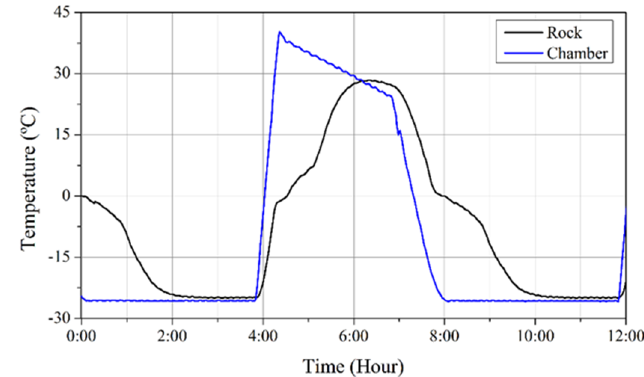
Figure 5. Temperature change test inside the rock during freeze-thaw cycles.